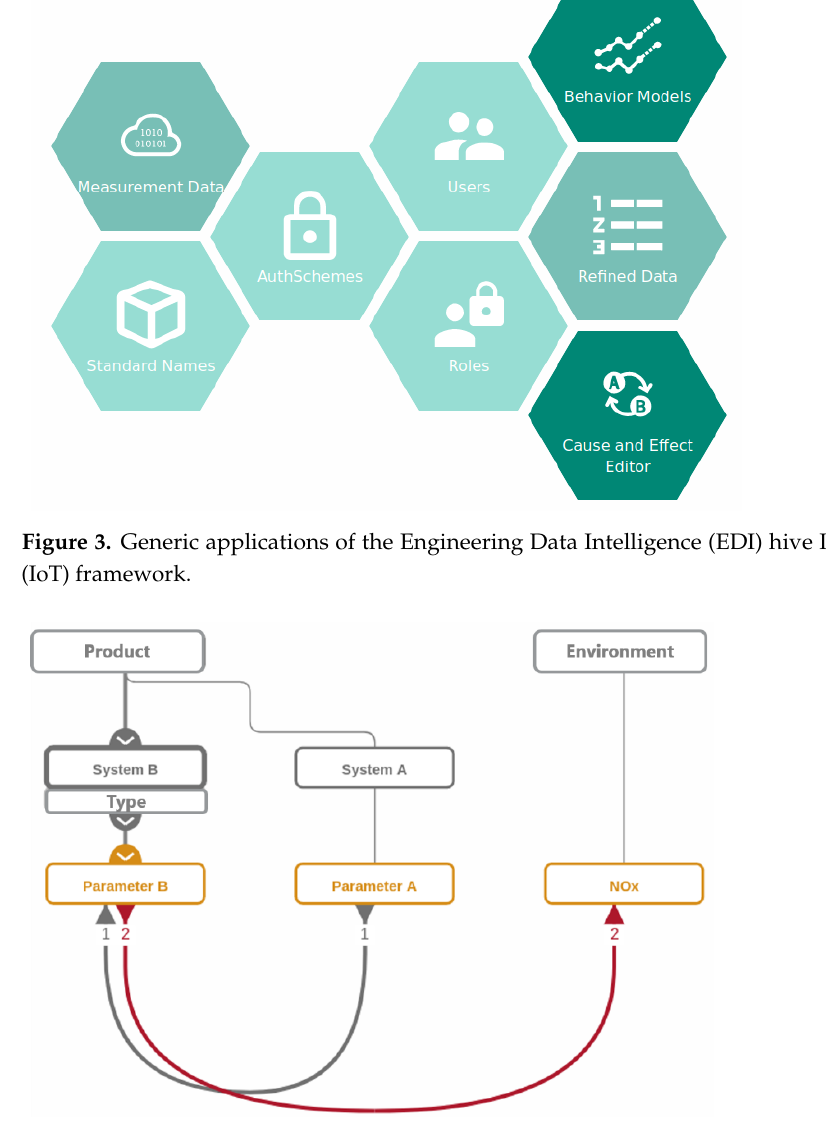
Figure 3. Generic applications of the Engineering Data Intelligence (EDI) hive Internet of Things (IoT) framework.